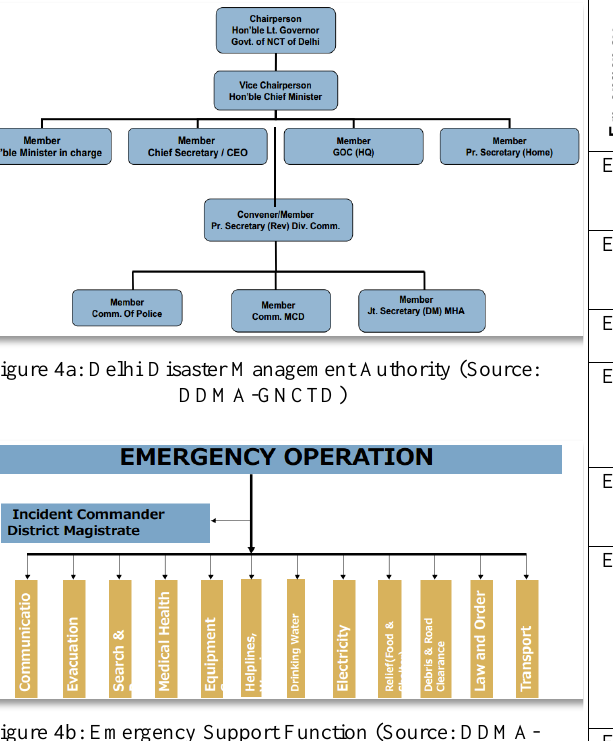
Figure 4b: Emergency Support Function (Source: DDMA- GNCTD)